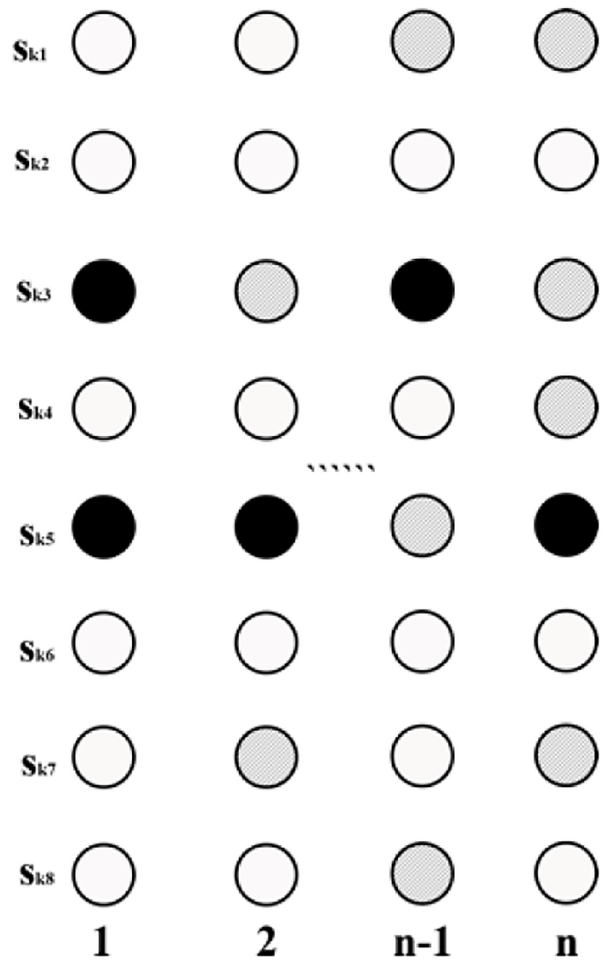
Fig 5. Optimized training data organization (a white node represents a channel facies value, a black node represents a background value, and a shaded node represents a null value).